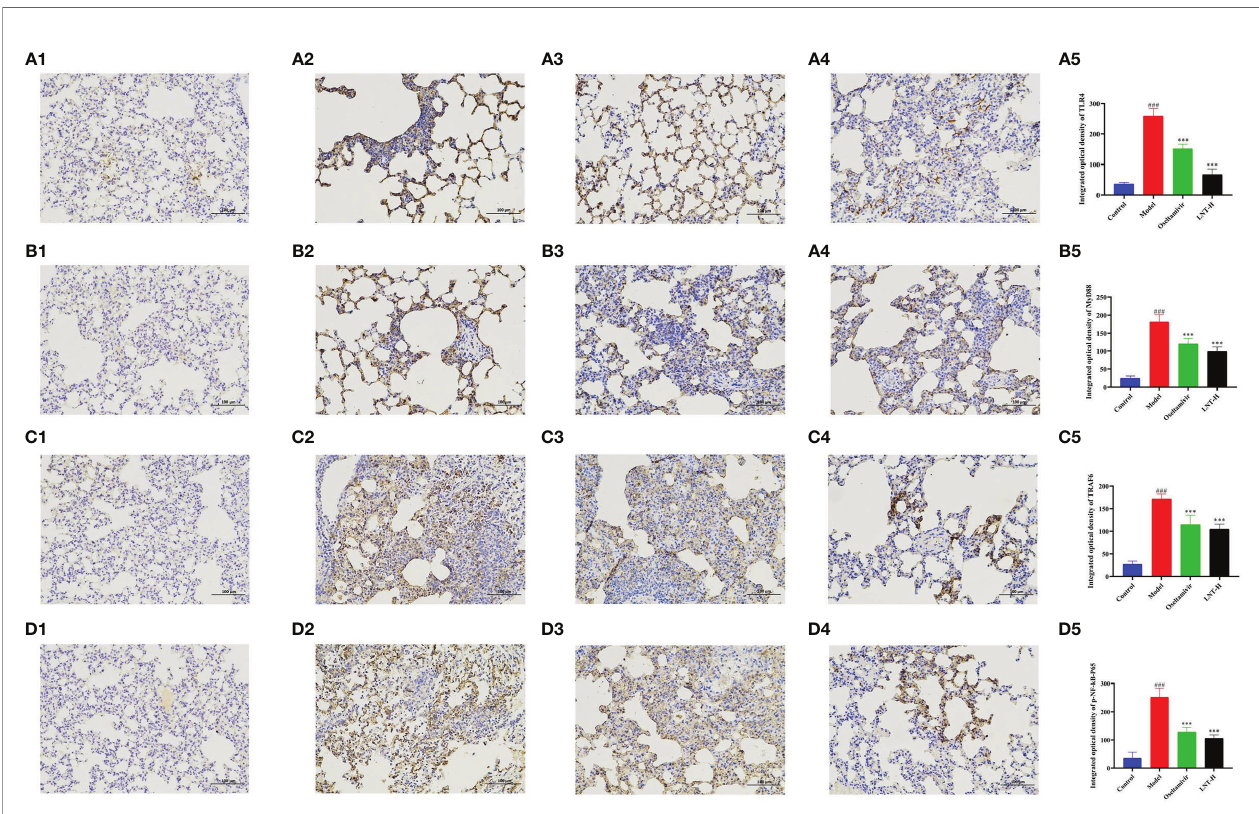
FIGURE 7 | Immunohistochemical staining observation of key proteins in theTLR4 signalingpathway inmouse lungtissue. Lungtissues of 5 dpi mice were collected and the expression levels of TLR4 (A) , MyD88 (B) , TRAF6 (C) and P-NF- k B P65 (D) inthe TLR4 signalingpathway were quantitatively analyzed byimmunohistochemical staining (200 x). A1, B1, C1, and D1represent the control group; A2, B2, C2, and D2represent the model group, A3, B3, C3, andD3represent oseltamivir group, A4, B4, C4, and D4 represent the LNT-H group; andA5, B5, C5, andD5represent the IODquanti fi cation results of brownpositive products. ### p < 0.001, vscontrol group(n=10);***p< 0.001, vs. model group